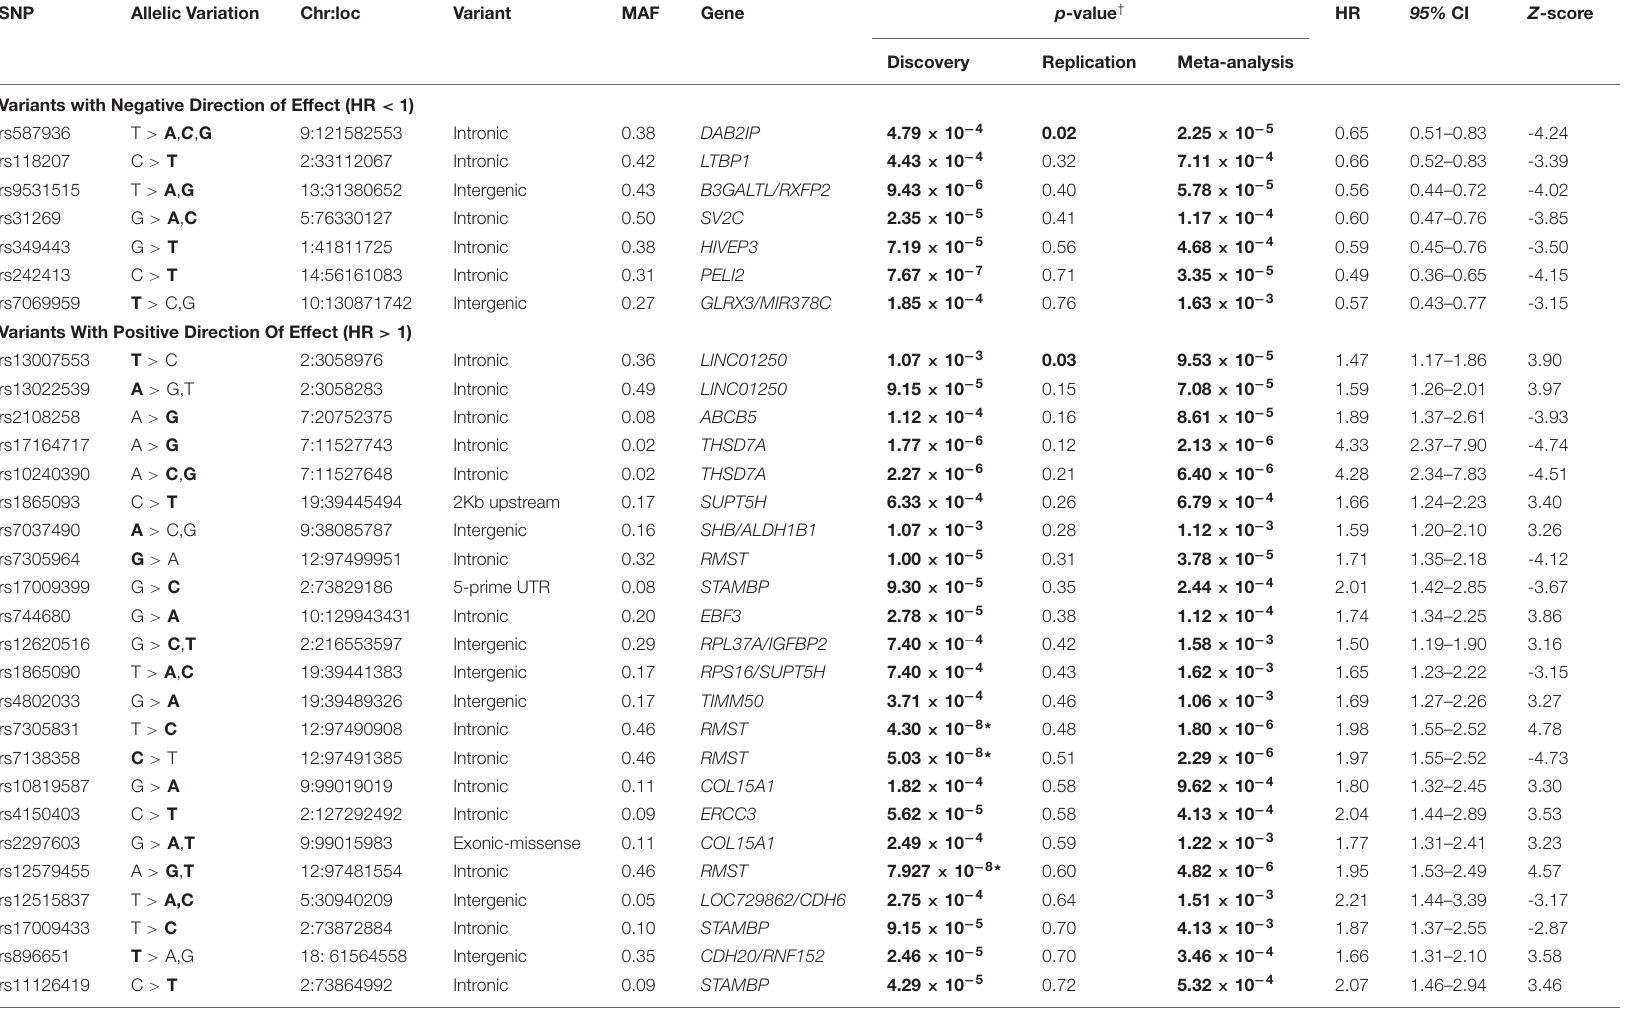
TABLE 2 | Clinically adjusted hazards of all-cause mortality among CAD cases for discovery-screened SNPs. Allelic Variation